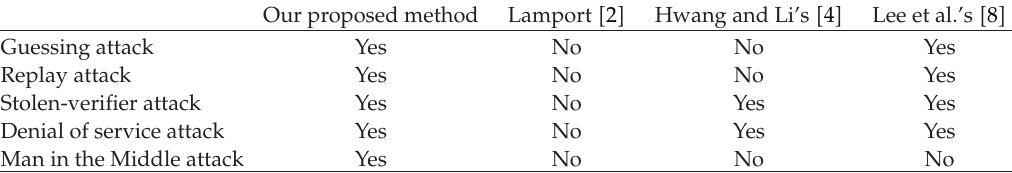
Table 2: Security comparison of the proposed scheme against some password authentication scheme. Our proposed